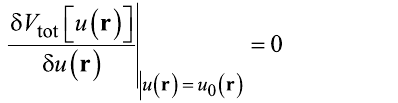
All expressions take the same value, −Δγ , for the